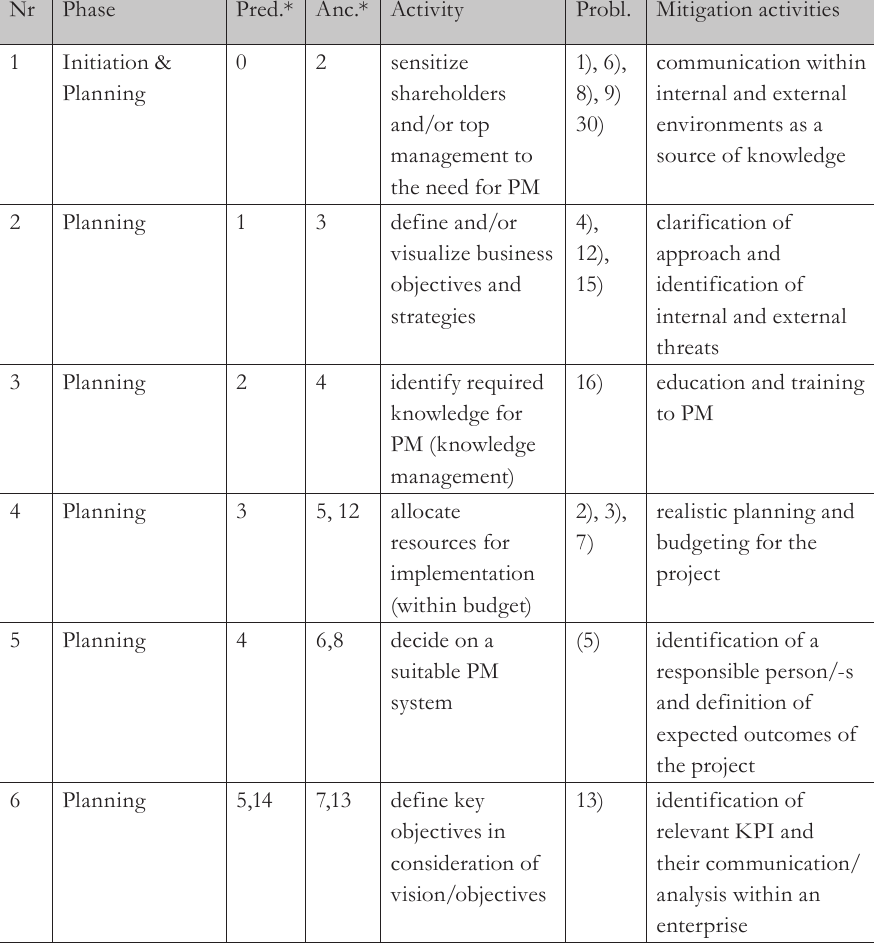
Tab. 4 – Problems during implementation and recommendations for avoidance. Source: own